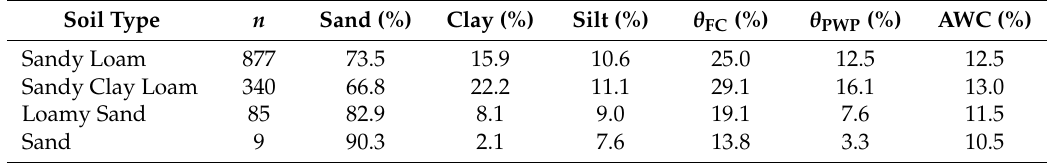
Table A1. Mean topsoil sand, clay, and silt content for the soil types identified in both watersheds. Soil Type n Sand